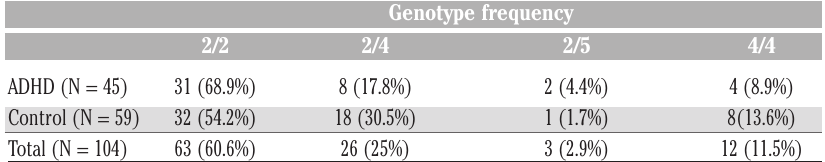
Table 3. Distributionof the DRD4 genotypes.